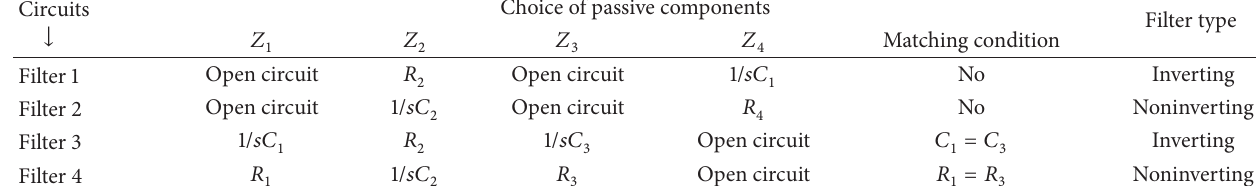
Table 1: First-order voltage-mode all-pass filters.